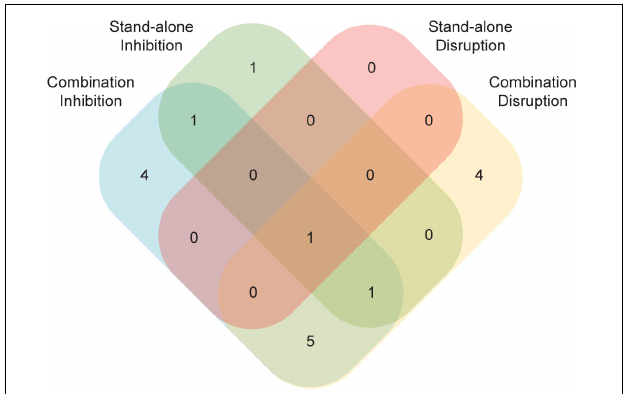
FIGURE 5 | A number of compounds had effects in just a subset of the four biofilm assays. Compounds with an effect in either the standalone or the combination versions of the Sustained Inhibition or Disruption Biofilm Assays are indicated. In total, 17 compounds had an effect in at least one of the four